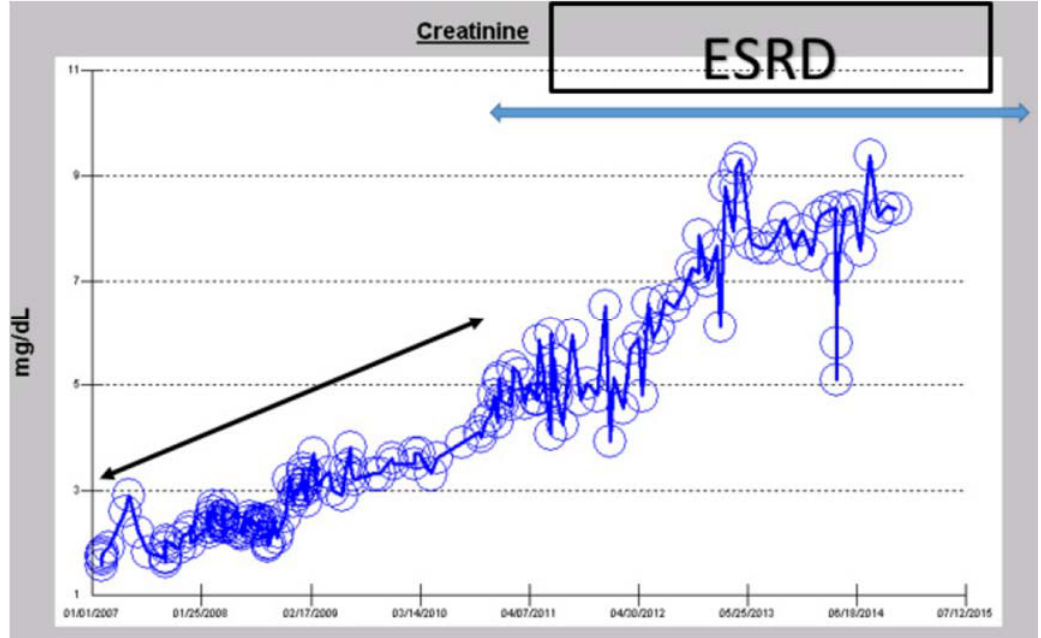
Figure 5. Serum creatinine trajectory in a now-56-year-old Caucasian